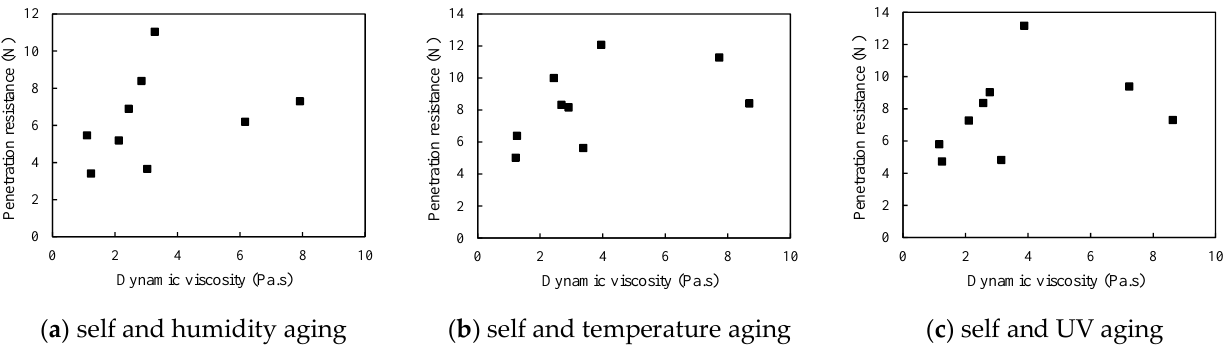
Figure 13. Penetration resistance vs. dynamic viscosity during multivariate aging. Table 8. ANOVA analysis of penetration resistance and dynamic viscosity.